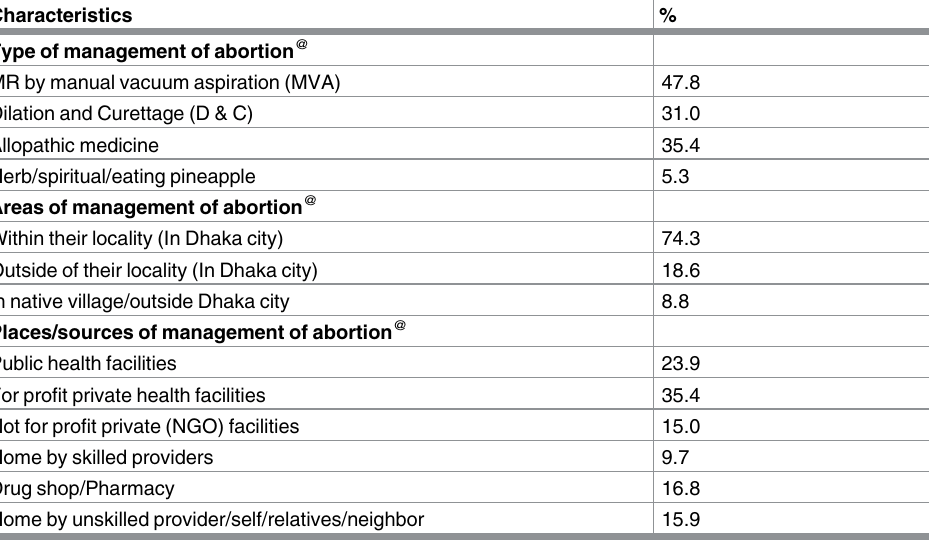
Table 3. Management of abortion among FSWs who reported having an abortion in last one year (n = 113).